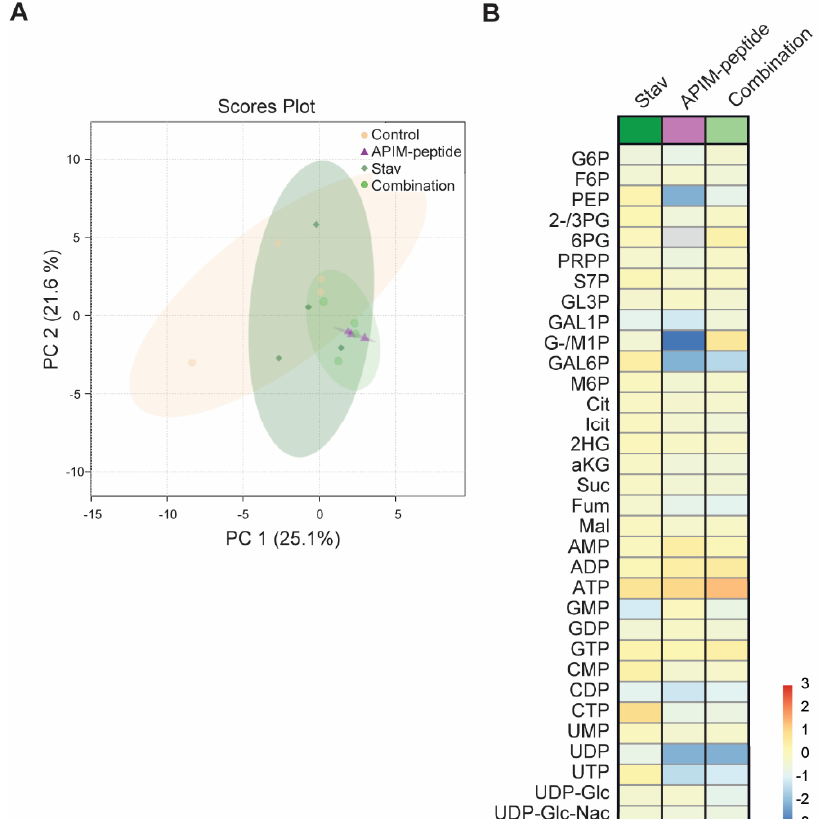
Figure 3. Stavudine treatment of Escherichia coli MG1655 leads to small changes in glycolytic, PPP and TCA intermediates and in nucleoside phosphate pools. ( A ) Scores plot (PC1 and PC2) from PCA of intracellular metabolite concentrations, as measured by capIC-MS/MS, for the four treatment groups: stavudine (Stav, 0.32 µ g/mL), APIM-peptide (26 µ g/mL) and combination (Stav + APIM-peptide) and untreated control harvested two hours after treatment, with 95% confidence regions indicated. ( B ) Log 2 fold change of treated cultures vs. untreated control. Data are averages of four independent biological replicas normalized by sum.